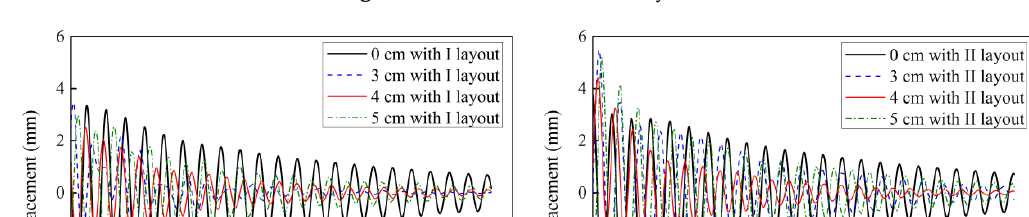
Figure 6. Three different PMs layouts.